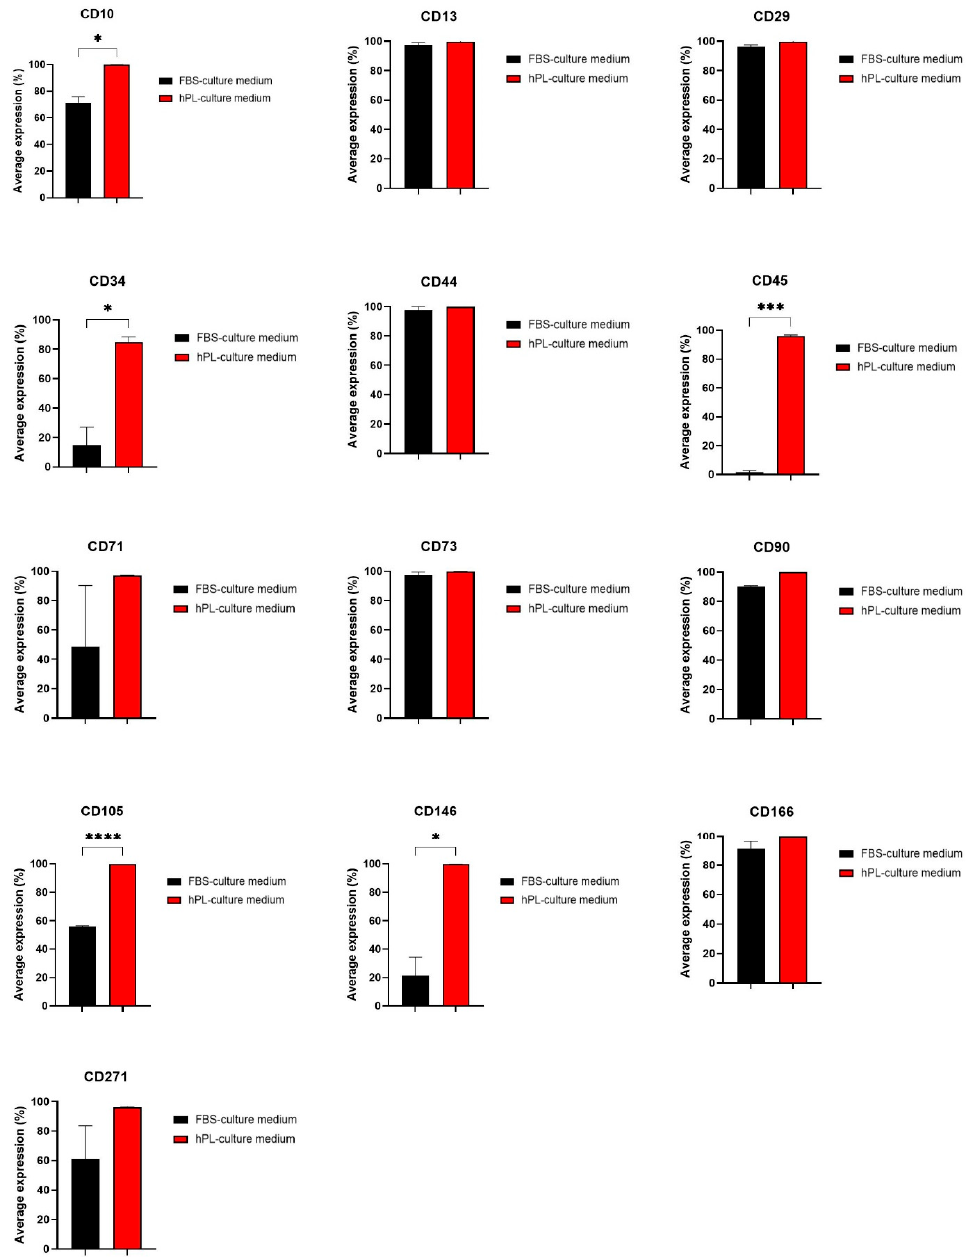
Figure 4. Phenotype profile measured in the 5th passage using flow cytometry. hNDP-SCs from both groups were stained with primary immunofluorescence antibodies conjugated with phycoerythrin (PE) or fluorescein (FITC) against the analyzed CD markers. The percentage of positive cells was determined as a percentage of cells with higher fluorescence intensity than the upper 0.5% isotype immunoglobulin control. Graphs depict the average expression of all analyzed CD markers. The data are presented as the mean ± SD. The Shapiro–Wilk test or Kolmogorov–Smirnov test were used for normal distribution evaluations. The statistical analyses were calculated using the paired t -test (* p < 0.05, *** p < 0.001, **** p <